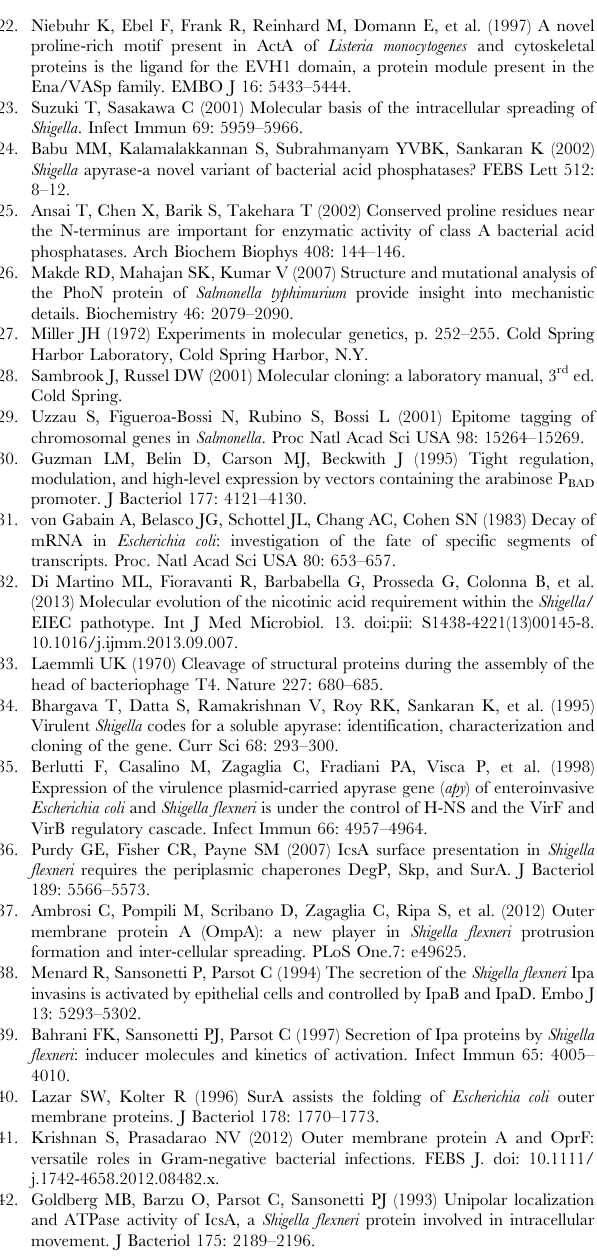
amounts of proteins were analyzed by Western blot. A protein molecular weight marker (Pierce) was used to determine the molecular weight of proteins. Immunoblotting was carried out using monoclonal anti-HA (Panels A and B) or polyclonal anti- OmpA antibodies (Panels C and D). Expression of phoN2 -HA was achieved by growing bacteria in the presence of 0.016% of L- [48]. The relative position of the PhoN2-HA-OmpA complex is indicated (right). Experiments were repeated at least three times and typical results are shown. Table S1 Bacterial/yeast strains and plasmids used in this work.